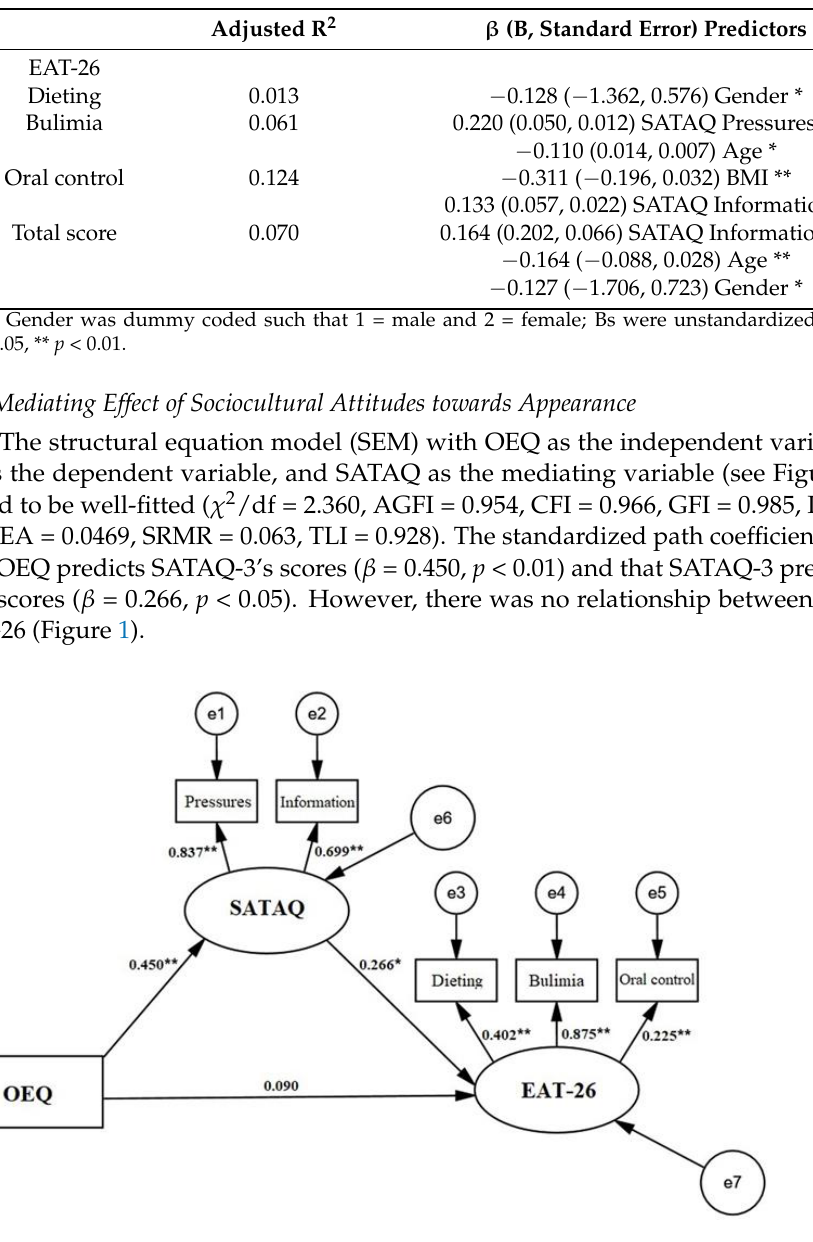
Figure 1. Path analysis of the relationship between OEQ, EAT-26, and SATAQ of participants.